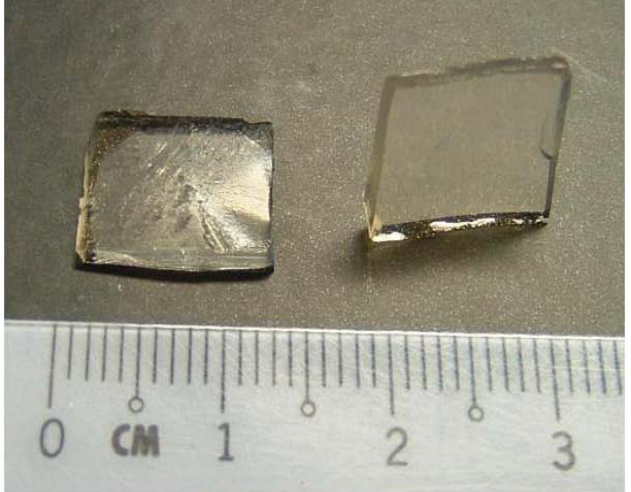
Figure 7. Photograph of CM-Hydrogel after irradiation for 1 hour. Left: Cross sectional view; right: Hydrogel standing on one of its